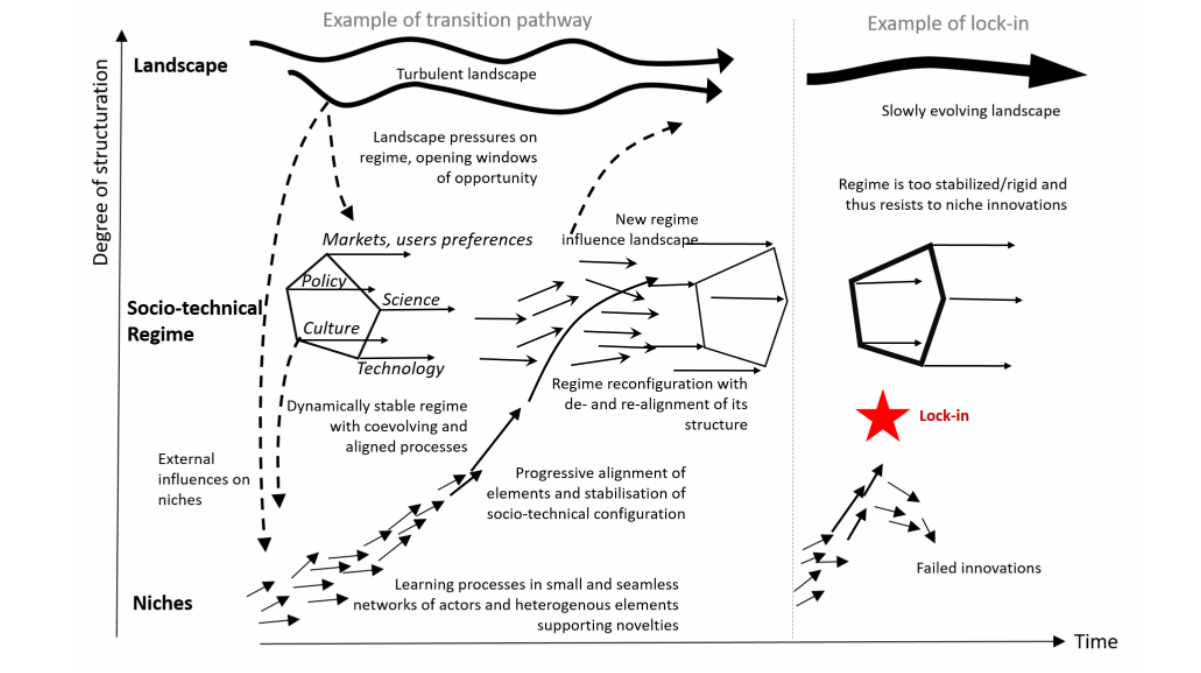
Fig. 3. The multilevel view of transitions. Adapted from Geels